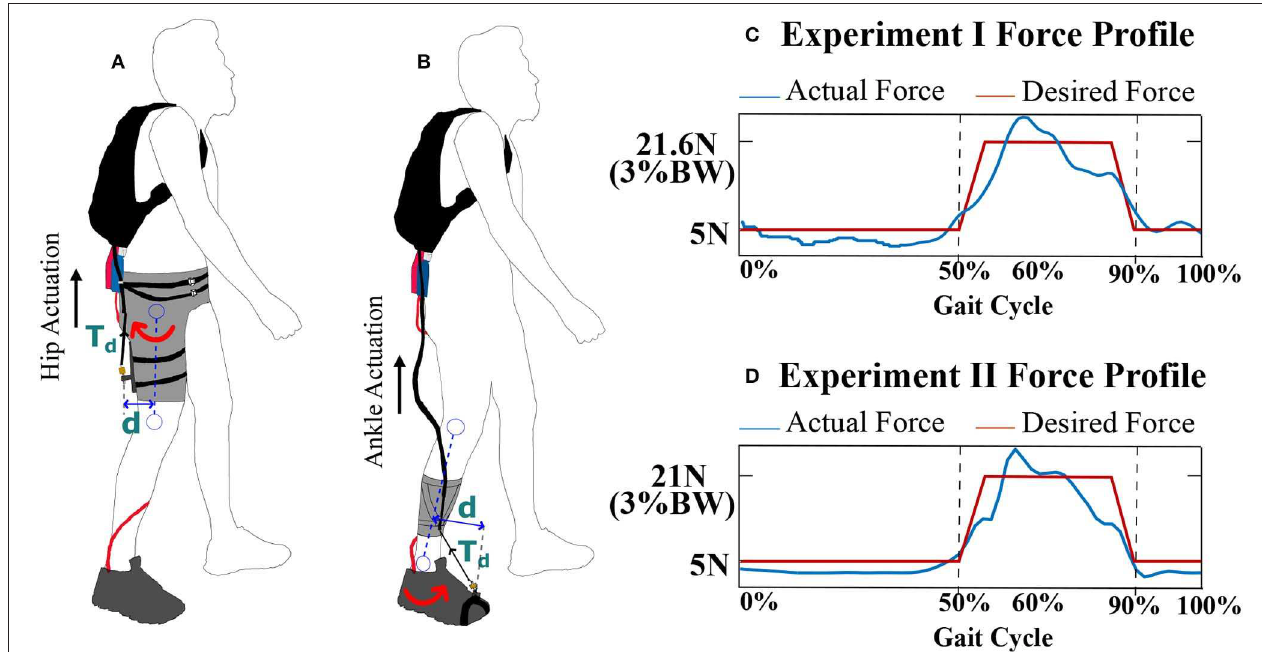
FIGURE 4 | (A) WeARS setup for the hip actuation experiment, Experiment I, with a thigh unit. (B) WeARS setup for the ankle actuation experiment, Experiment II, with a calf unit and shoe with an anchor point to attach the cable. T d = Tension , Wrench = T d × d . (C) The desired and actual force variation during a walking trial of Experiment I for a participant with a weight of 72 kg, 3%BW equals 21.6N. (D) The desired and actual force variation during a walking trial of Experiment II for a participant with a weight of 70 kg, 3%BW equals 21 N. BW is body weight.